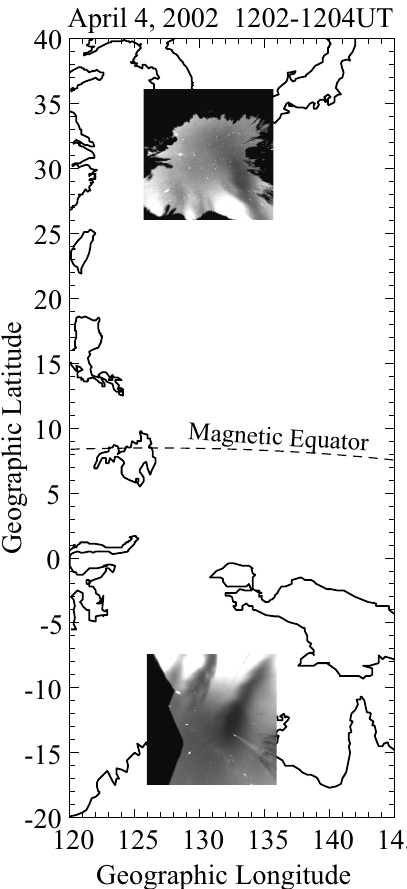
Fig. 2. Plasma bubble images (in count rate) at Sata and Darwin on a geographical map. These images were obtained at 12:04 UT (Sata) and 12:02 UT (Darwin) on 4 April 2002. Note that the bubbles show latitudinal tilts, forming backward